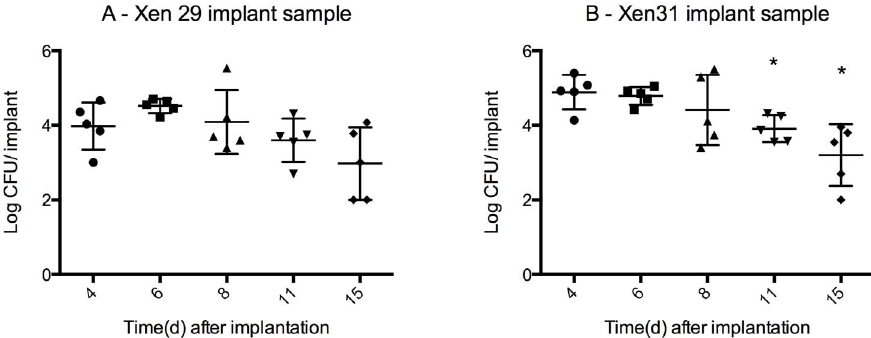
Figure 5. Bacterial load from implants mean CFU 6 SD (logarithmic scale). The bacteria found in biofilms along the surface of the pin was released with ultrasonication and grown for 24 h at 35C. The pins were washed in saline prior to sonication thus the bacterial load solely represents bacteria from biofilms formed on the surface of the pin. Mean pin weight 0.002 6 0.0001 g. Approximate bacterial load for all samples is 4 log CFU/ implant from day 4–11 for both X29 and X31. The bacterial load is significantly lower for X31 for day 11 (P=0.006) and 15 (P=0.004) when compared to day 4, but it remains stable from day 8–15 (no significant change in mean, P=0.07 one way ANOVA). Xen29 exhibits a similar stabile bacterial load from day 8–15 (no significant difference in means, P=0.14 one way ANOVA) n=5 for each group.